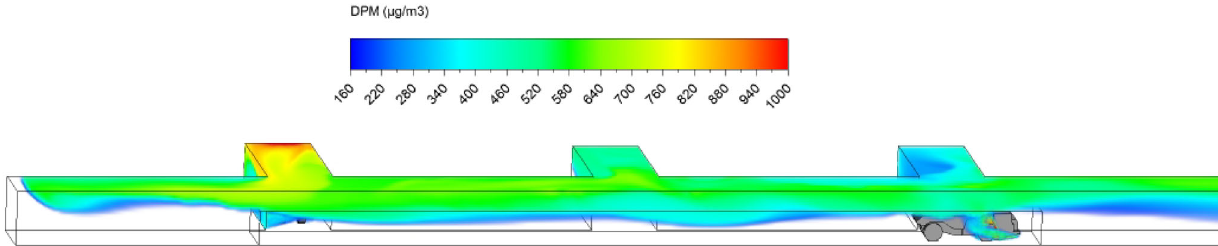
Fig. 19 DPM distributions in scenario 2 during the hauling operation at 240